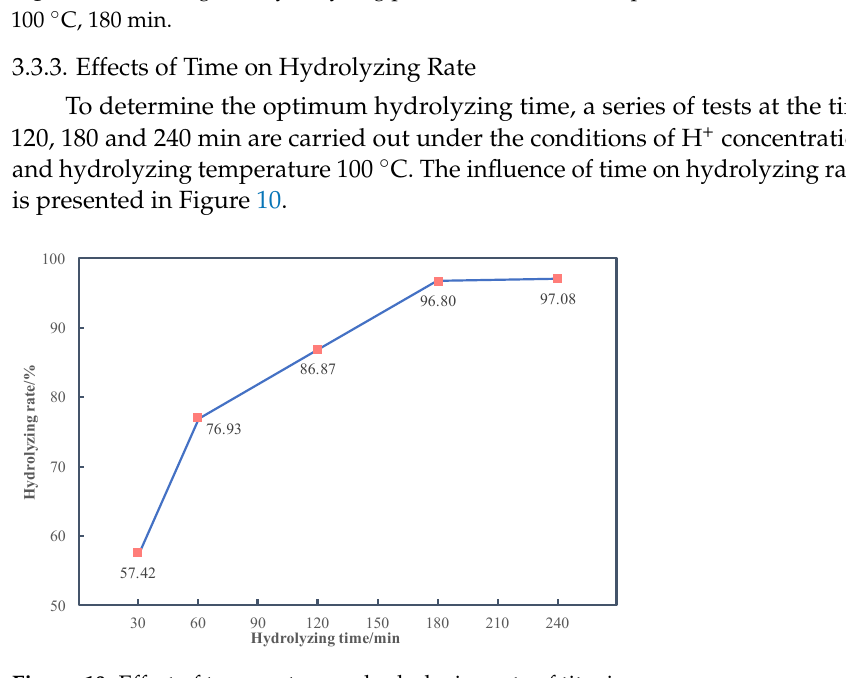
( b ) Figure 11. SEM images of hydrolyzing product at different times: ( a ) 100 °C, 30 min and ( b ) 100 °C, 120 min. 4. Conclusions According to the comprehensive comparisons at a series of experimental conditions, the optimum conditions for leaching experiments are obtained as follows: the acid/slag ratio of 4:1, the leaching temperature of 60 °C, the leaching time of 80 min and the liq- uid/solid ratio of 3.2:1. Under the above conditions, the leaching rate of titanium in Ti-